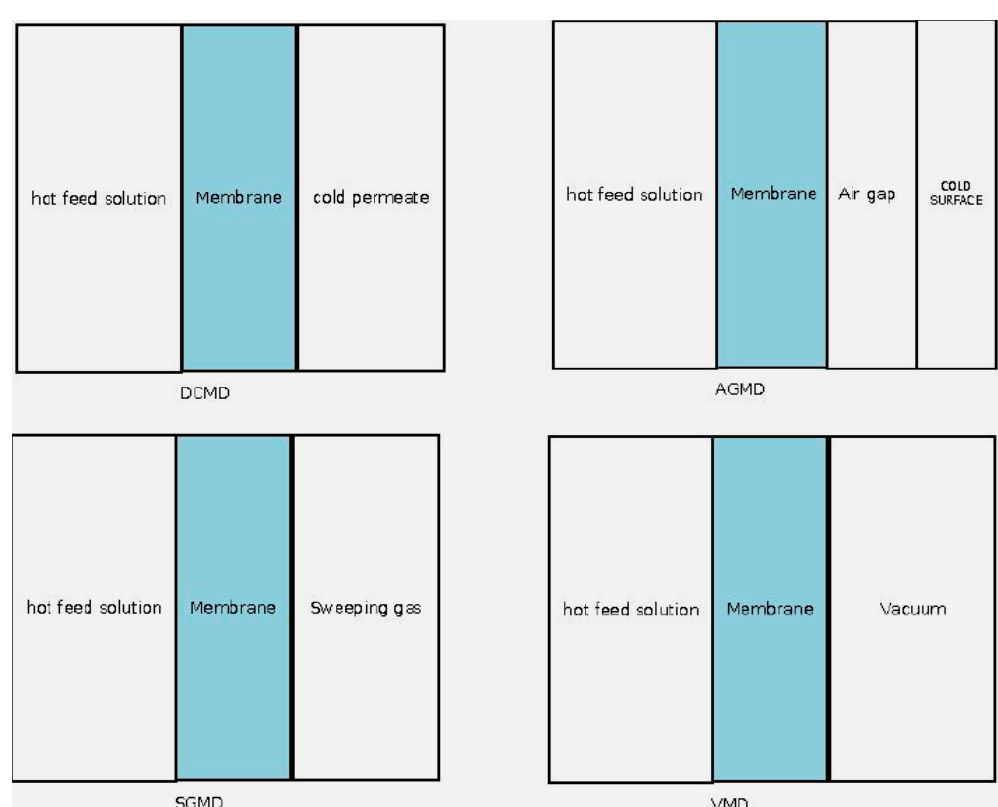
Figure 13. Schematic representation of MD configurations [2].